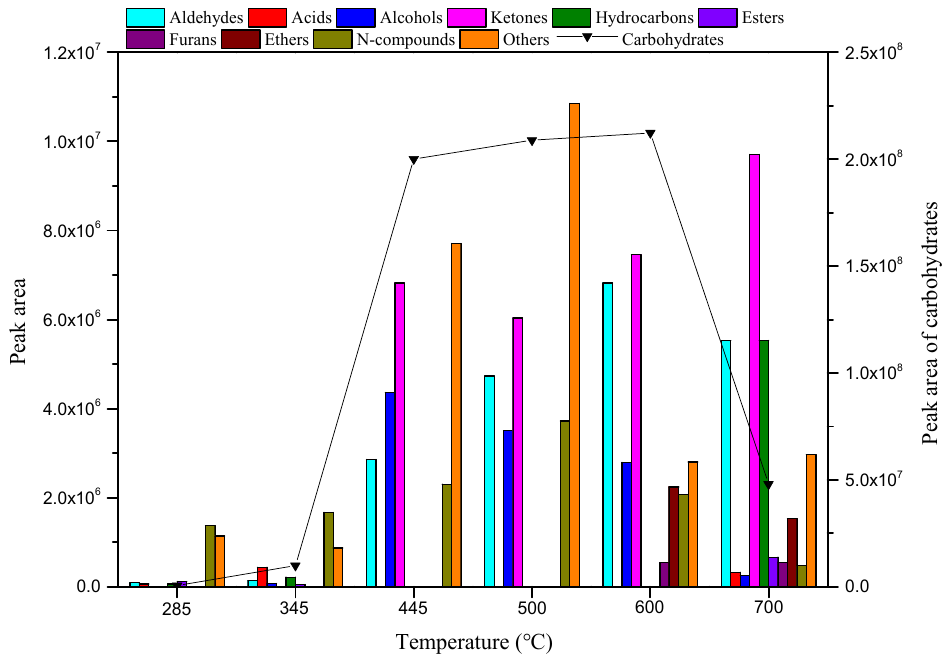
Figure 3. Yields of various compounds in bio-oil derived from MC pyrolysis at different temperatures for 10 s.